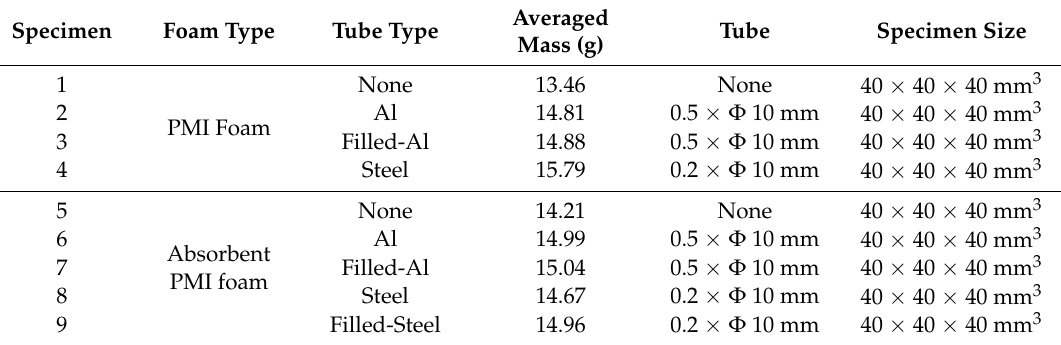
Figure 2. The wave-absorbing properties of normal and absorbent PMI foams; ( a ) Experimental setup; ( b ) Experimental results of reflectivity for vertical incident waves. Table 1. Parameters of specimens for the compression tests; Al is 6061 aluminum alloy, steel is 304 stainless steel, Filled-Al is foam-filled aluminum tube, Filled-Steel is foam-filled 304 stainless steel tube.